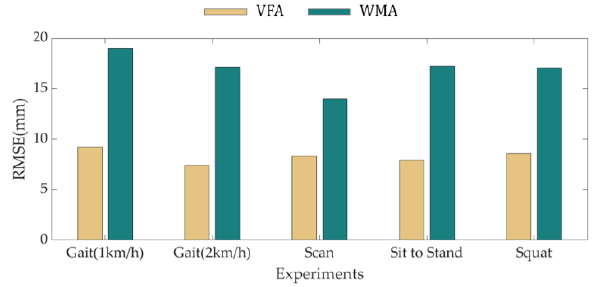
Figure 8. Bar graph of the average RMSE during experiments of all subjects by the VFA (Yellow bar) and the WMA (Green bar).